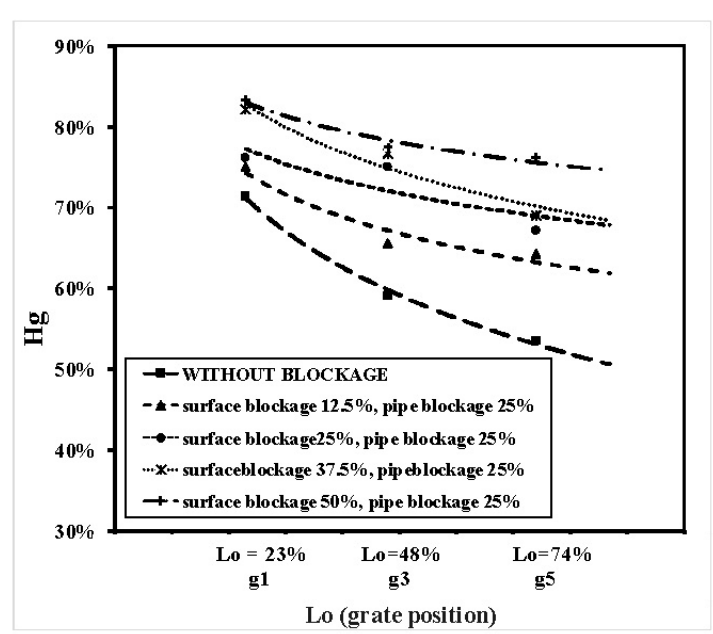
ff erent ratios of grate blockage with pipe blockage